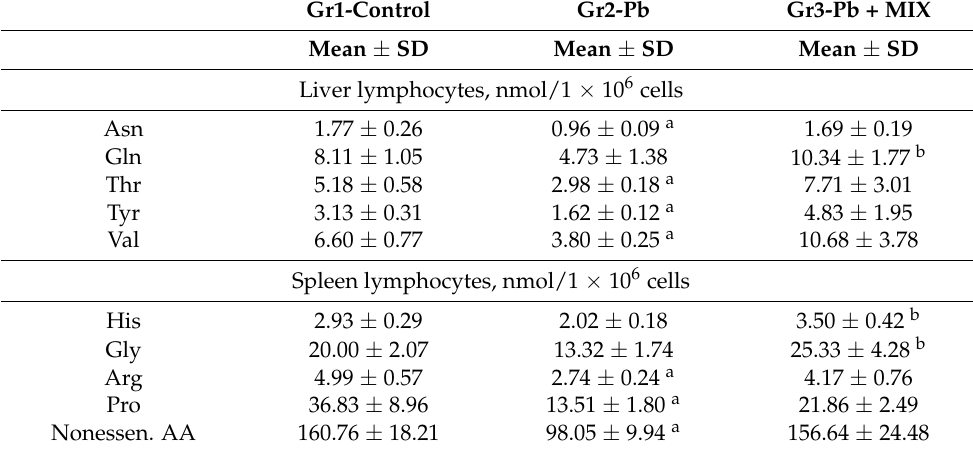
Table 1. The changes of the biomarkers evaluated in liver lymphocytes and spleen lymphocytes.